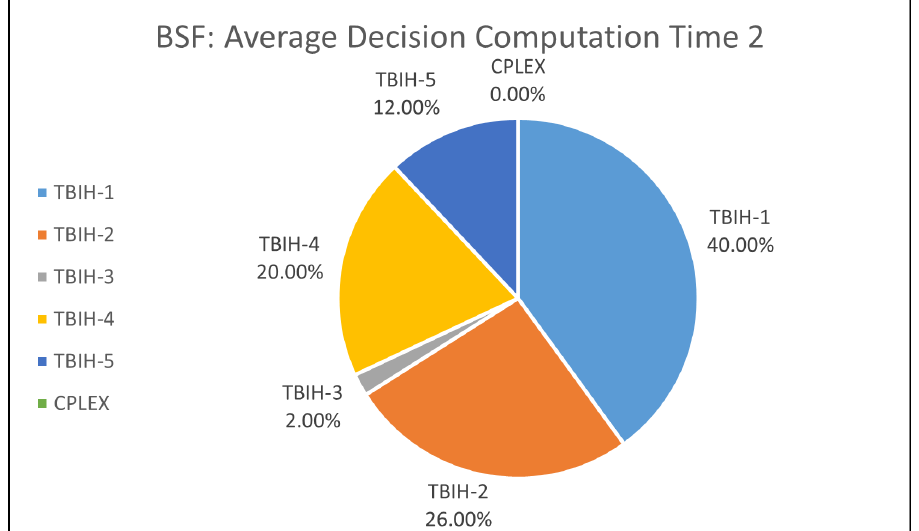
Figure A27. Algorithms performance compared to matheuristic rollout applied in PDS-RA: total BSF measured for average decision computation time over all test instances applied (including 10 non-benchmarked